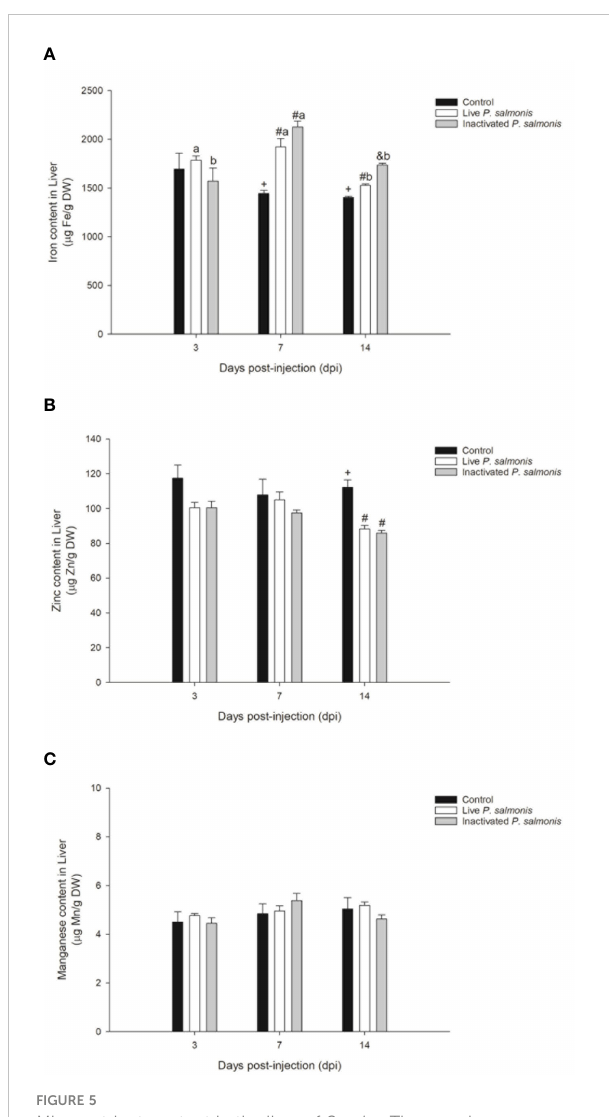
FIGURE 5 Micronutrient content in the liver of S. salar . The samples were taken at 3, 7 and 14 days after injection (dpi). Black bar: control condition, white bar ( fi sh stimulated with live P. salmonis ) and gray bar ( fi sh stimulated with inactivated P. salmonis ). (A) : iron. (B) : zinc. (C) : manganese. Symbols (+, #, &) over the bars indicate statistical differences between the different treatments at the same time points. Different letters a, b indicate statistical differences in the same treatment at different times. Two-way ANOVA, p < 0.05;